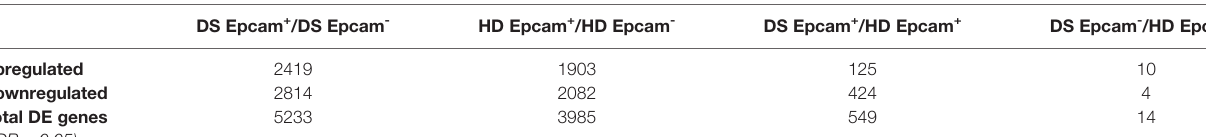
TABLE 2 | Differentially expressed genes at FDR < 0.05.